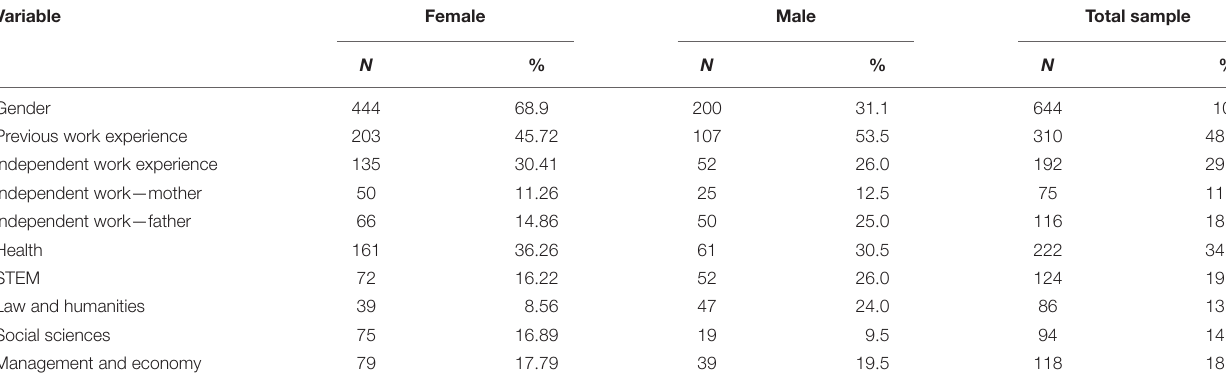
TABLE 1 | Sociodemographic data.